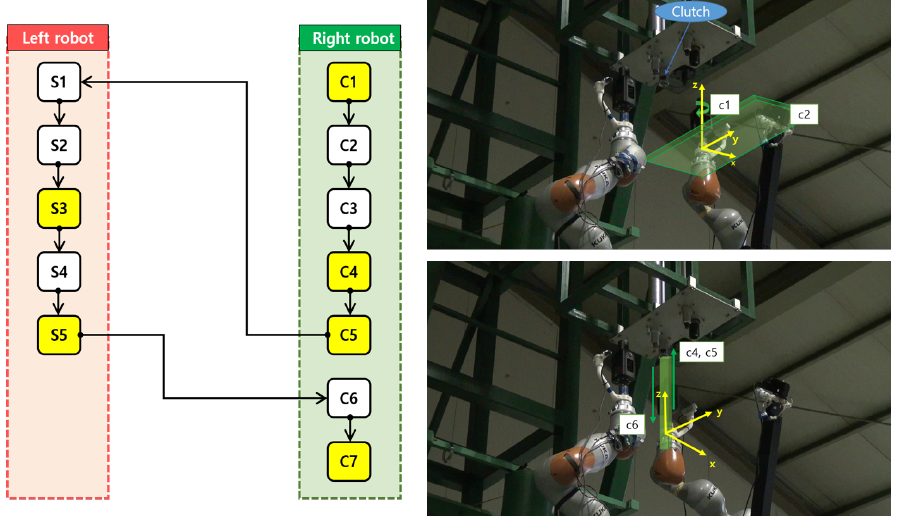
Figure 1. The sequence diagram of MADMOFEM task with dual-arm teleoperation system ( left picture ); when using the hybrid controller, position control is applied in the state of the white box, and speed control is applied in the state of the yellow box. State description of clutch operations in a real-world task environment ( right picture